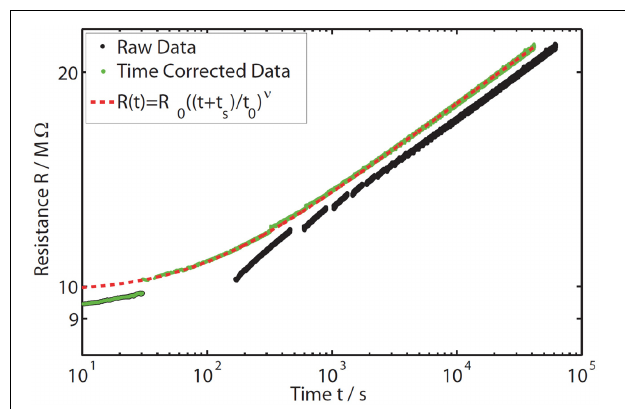
FIGURE 7 | Time-resolved resistance data measured on a GeTe sample at 80 ◦ C annealing temperature (black data points). Due to the interruption of the annealing process during the temperature dips, the data do not follow the extended power law (red dashed line). Therefore, the time values of the raw data are corrected to reflect only the duration spent at the constant annealing temperature (green data points). The corrected data fit the previously determined drift exponent of the extended power law (in the constant annealing temperature experiments at 80 ◦ C in GeTe) quite well, except for the first 30s (deviation between green curve and red dashed line). During these first seconds, the resistance drift occurs also at temperatures lower than the annealing temperature (i.e., during the temperature dip) and thus changes the absolute resistance value after the dip. This is why the data taken during the first dip were not taken into account in the data